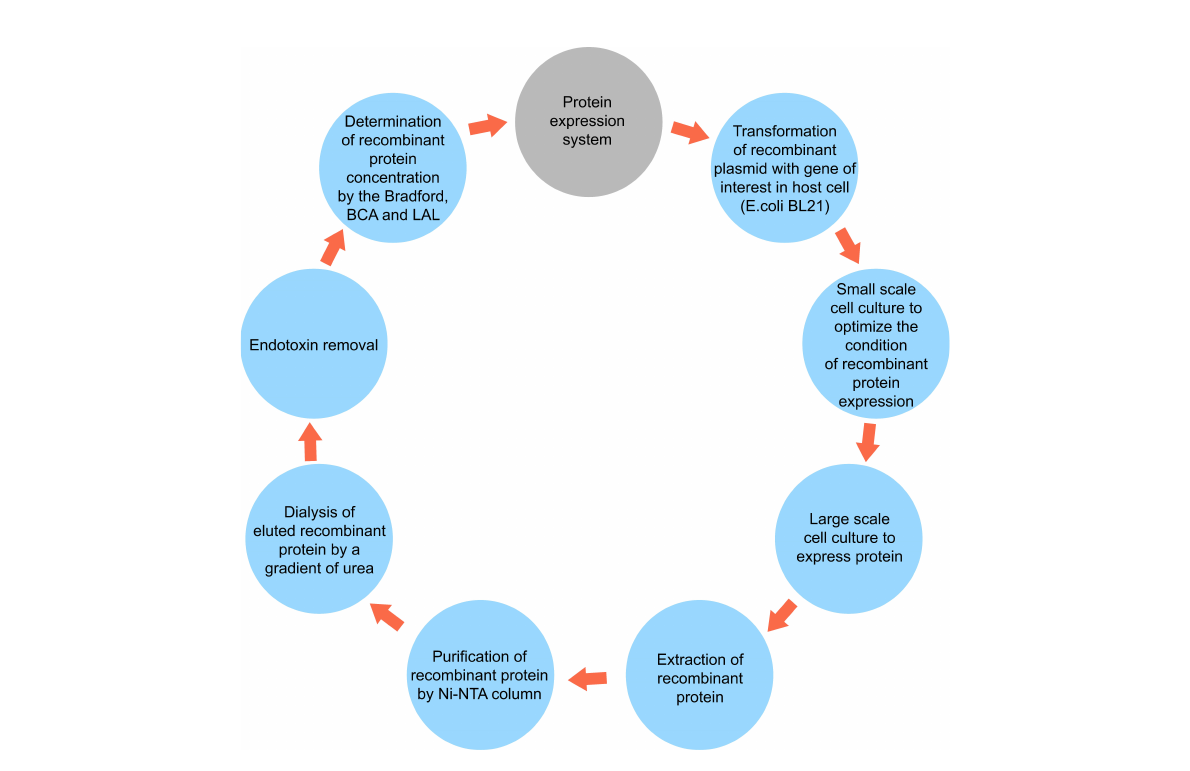
FIGURE 1 A simpli fi ed schematic diagram of protein expression system including extraction and puri fi